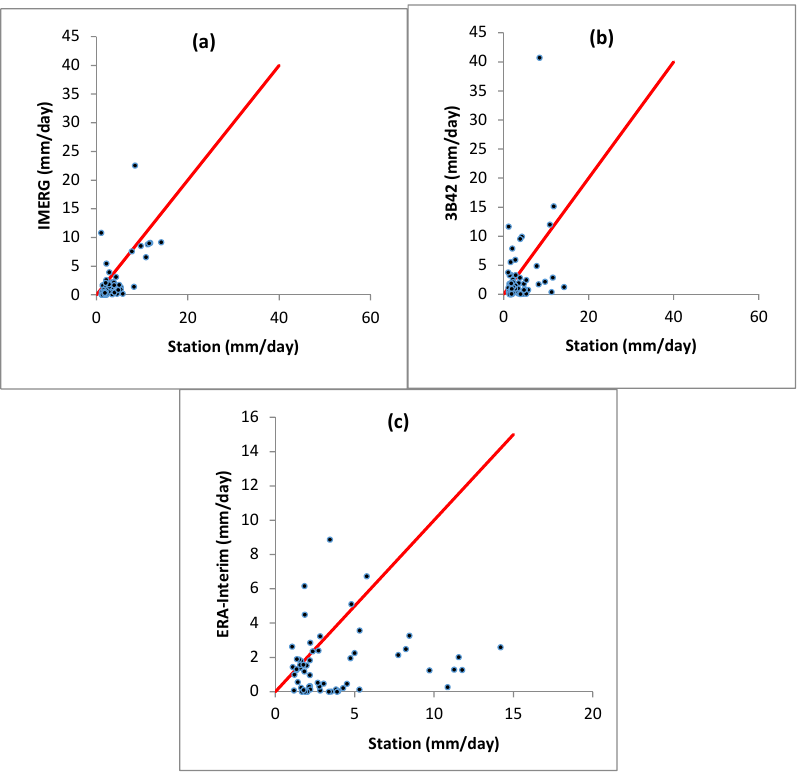
Figure 7. Daily precipitation events scatter plots for Tehran of IMERG ( a ); 3B42 ( b ) and ERA-Interim ( c ) against gauge data (mid-March 2014 to February 2015). Table 4. Statistical indices of daily precipitation events in Guilan area (mid-March 2014 to February 2015).